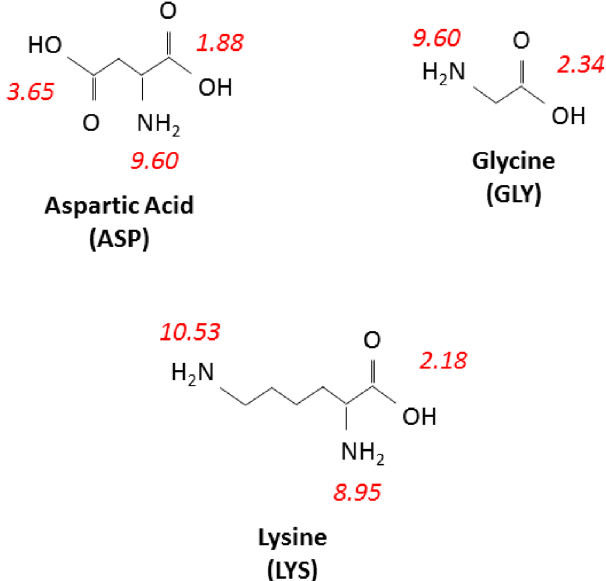
Figure 8. Molecular structure of Aspartic acid, Glycine, and Lysine with pK a values of amine and carboxyl groups represented near corresponding functional groups (pK a values from Nelson et al . 31